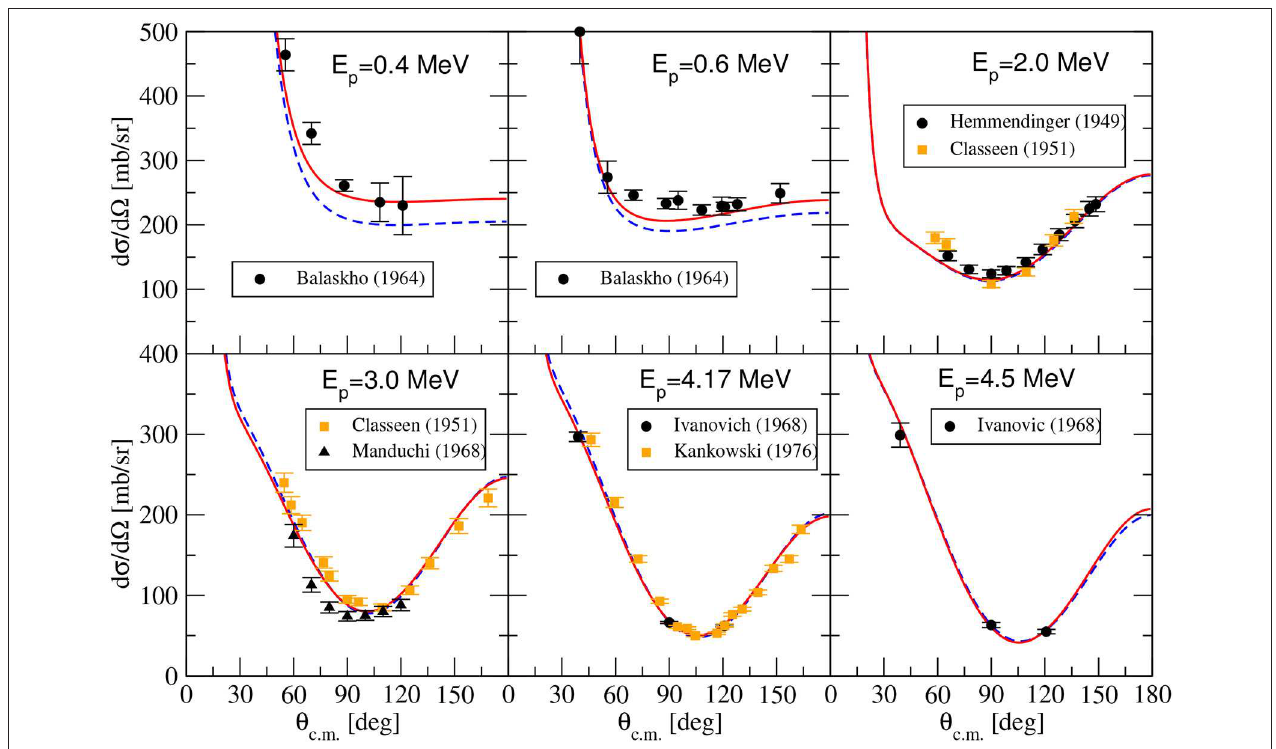
FIGURE 7 | p − 3 H differential cross section at several values of the proton laboratory beam energy E p , calculated with the N3LO-I (dashed blue lines) and with the N3LO-I/N2LO (solid red lines) interactions. The experimental data are from references [100–105].